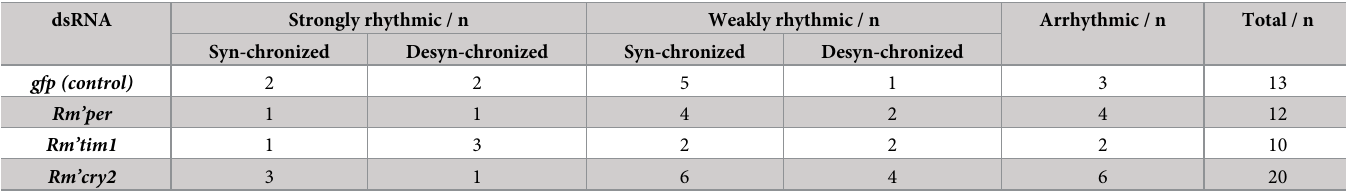
Table 2. Rhythmicity of free-running locomotor activity rhythms in controls and experimental animals.